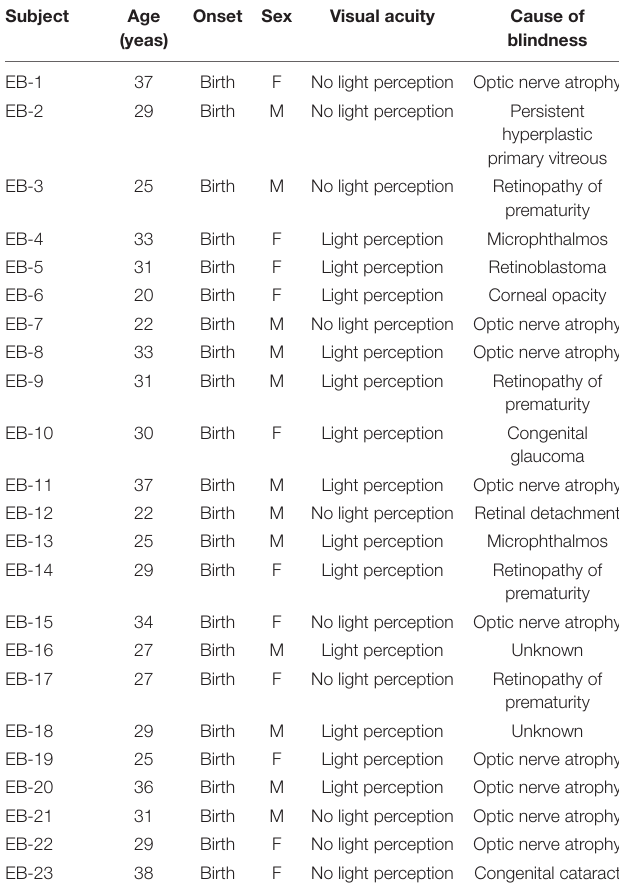
TABLE 1 | Clinical characteristics for the early-blind (EB)